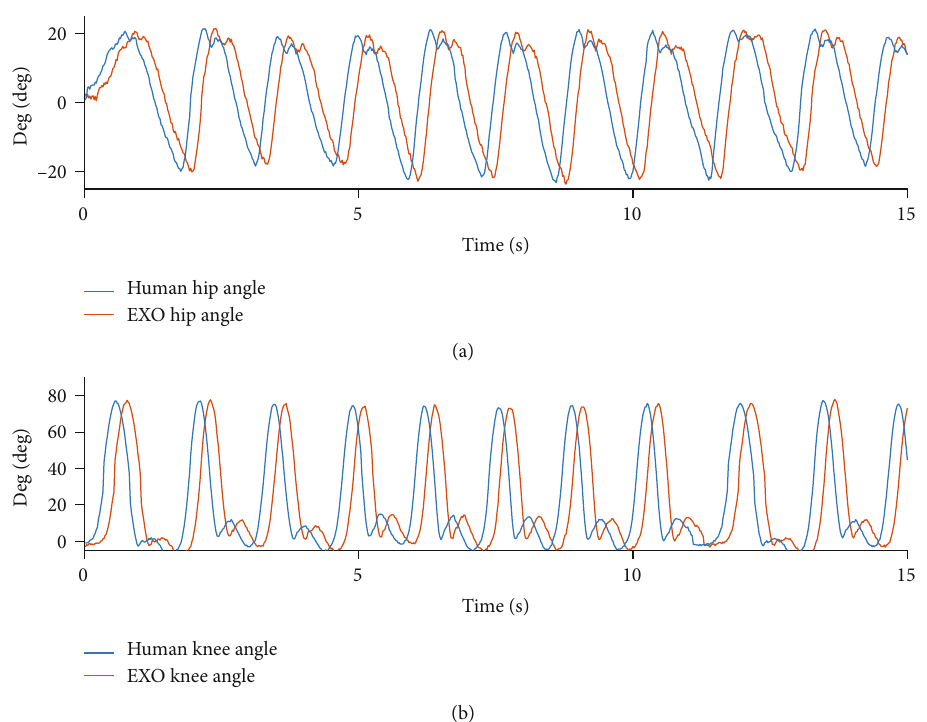
Figure 7: Joint angle deviation between human and exoskeleton.